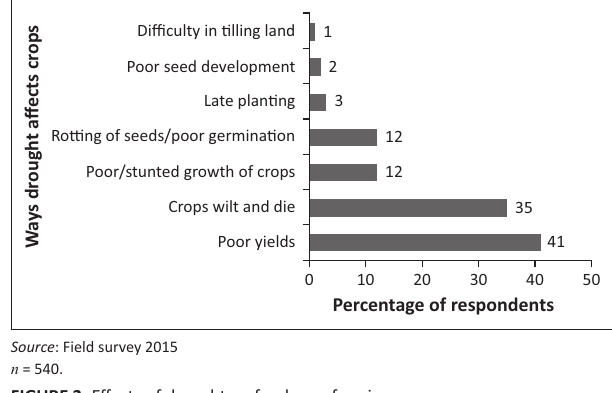
FIGURE 2: Effects of drought on food crop